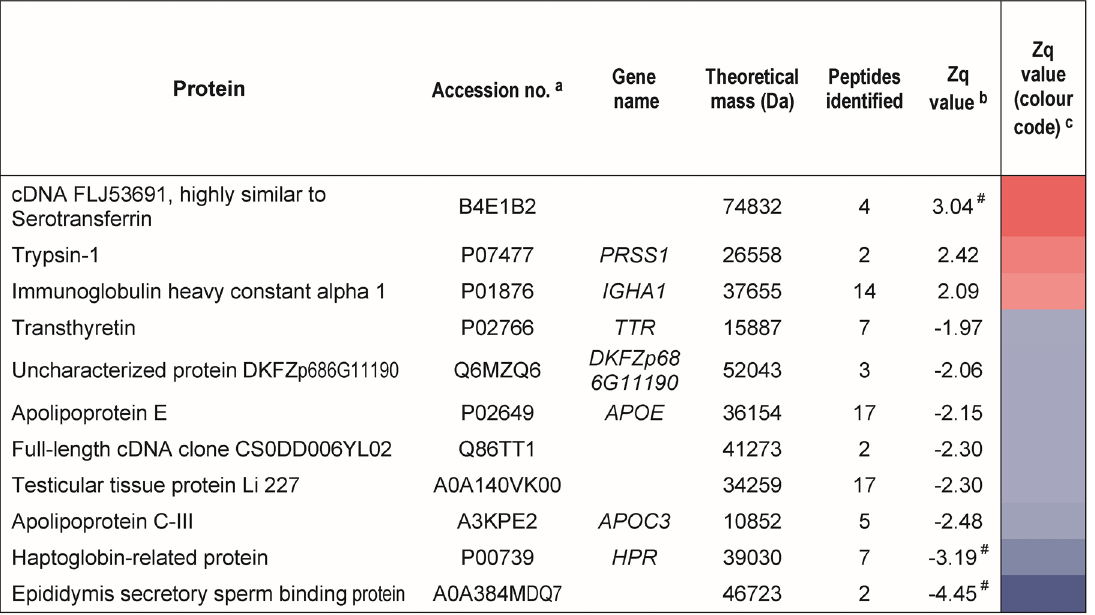
Table 3. Proteins with abundance changes in plasma samples of HDF compared with HF patients in LC–MS/ MS analysis. a Accession number in UniProt database (https ://www.unipr ot.org). b Protein quantification values (Zq) are normalized log2-ratios expressed in standard deviation units: Zq > 0 and Zq < 0 indicate increased or decreased, respectively, protein abundance in HDF compared with HF patients. c Zq values in a colour scale; red and blue represent increased or decreased levels, respectively, in HDF compared with HF. Zq ≥ 2, and ≤ −2, were significant ( p ≤ 0.05); # significant FDRq value (<